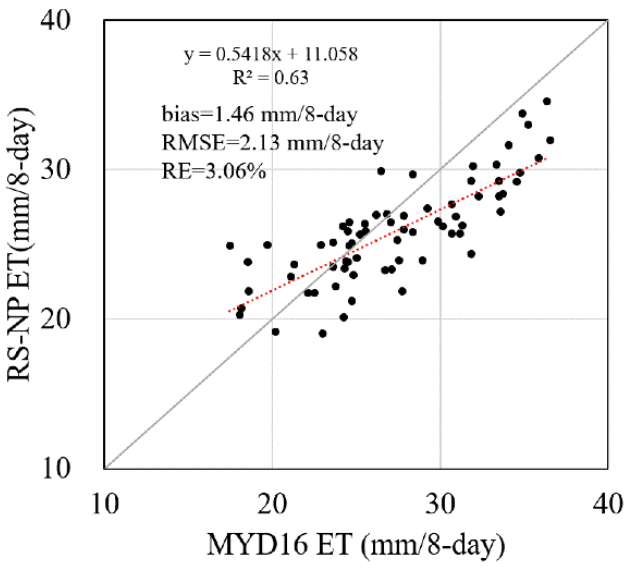
Figure 2. Comparison of consistency and difference between RS-NP retrieval ET (mm/8-day) and MYD16 ET (mm/8-day).